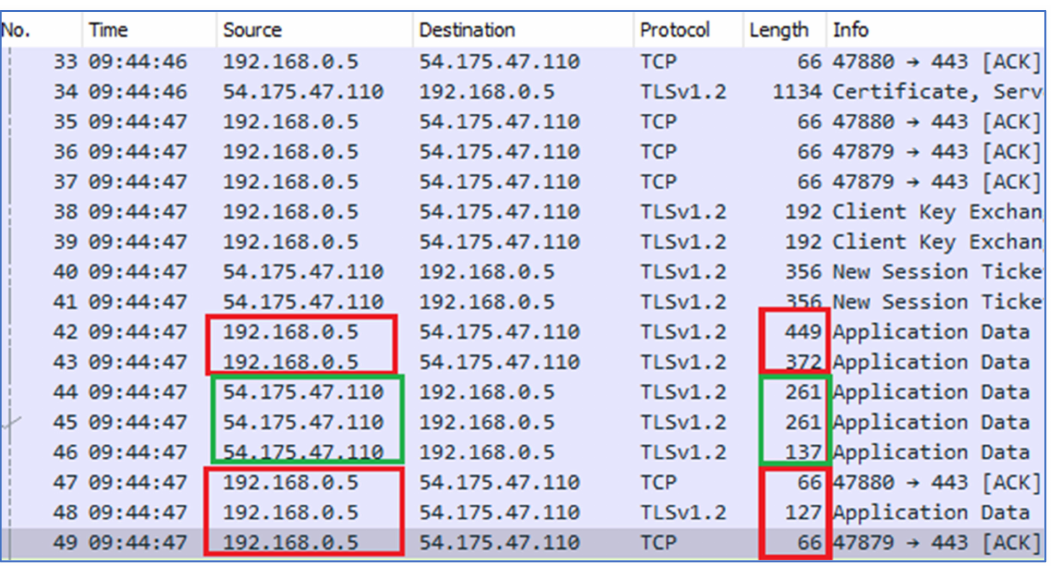
Figure 6. Opening/accessing the Signal